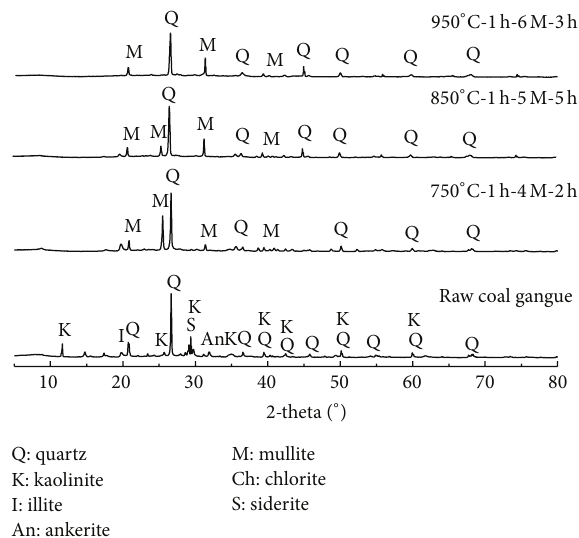
Figure 2: X-ray diffraction of the raw coal gangue and coal gangue after acid leach and typical chemical formula of the mineral components: quartz (SiO 2 ), illite (KAl 2 [(Al,Si)Si 3 O 10 ]), kaolinite (Al 2 Si 2 O 5 (OH) 4 ),ankerite(CaMg(CO 3 ) 2 ),mullite(Al6Si2O13),and siderite (FeCO 3